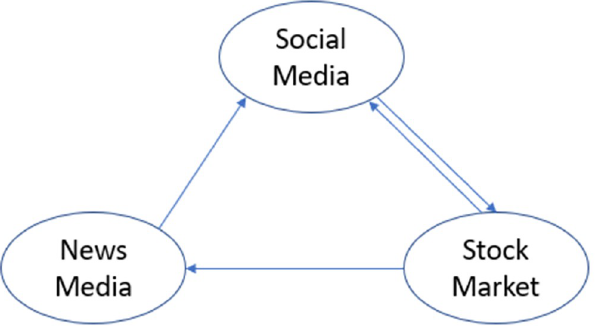
Fig 6. Theoretical information flux in which the results from Table 2 demonstrate information flow from social media towards stock price and in some cases information flow from stock market towards social media.